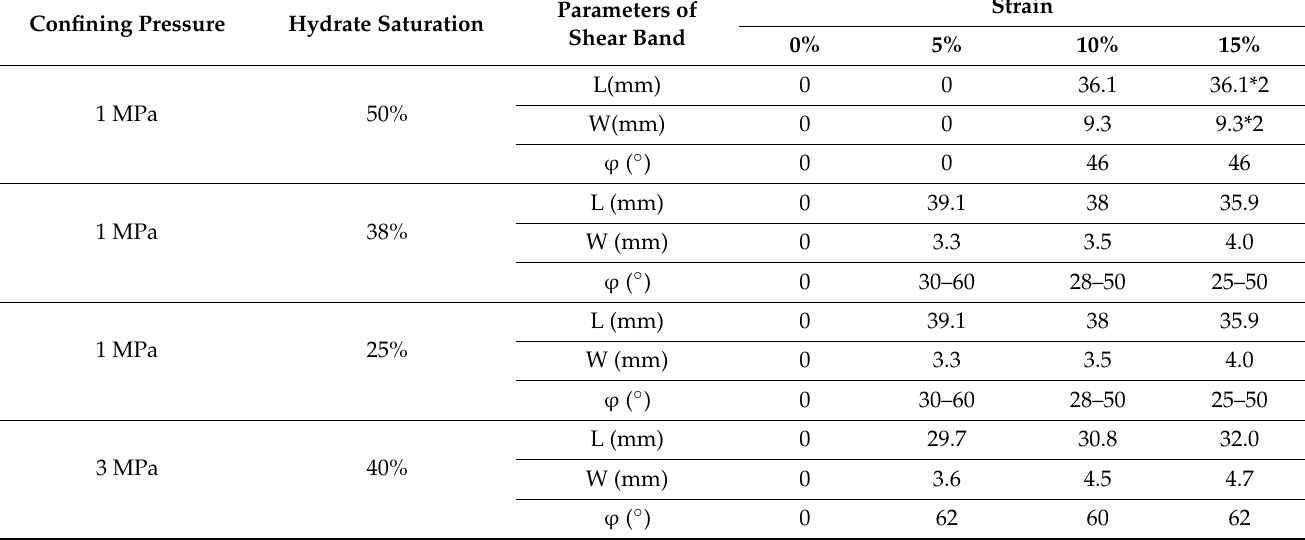
Table 1. The development of shear banding in geometrical